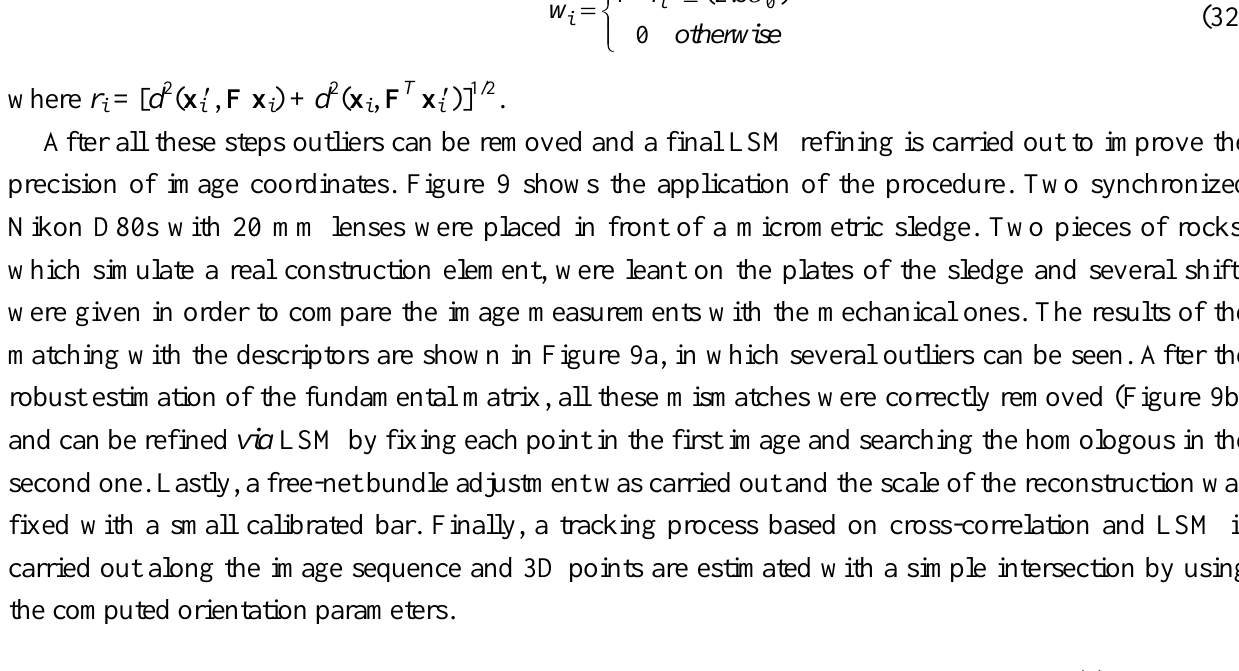
Figure 9. Matching results during a markerless 3D survey with two cameras: (a) point matched with the descriptors and (b) points after the robust estimation of the fundamental